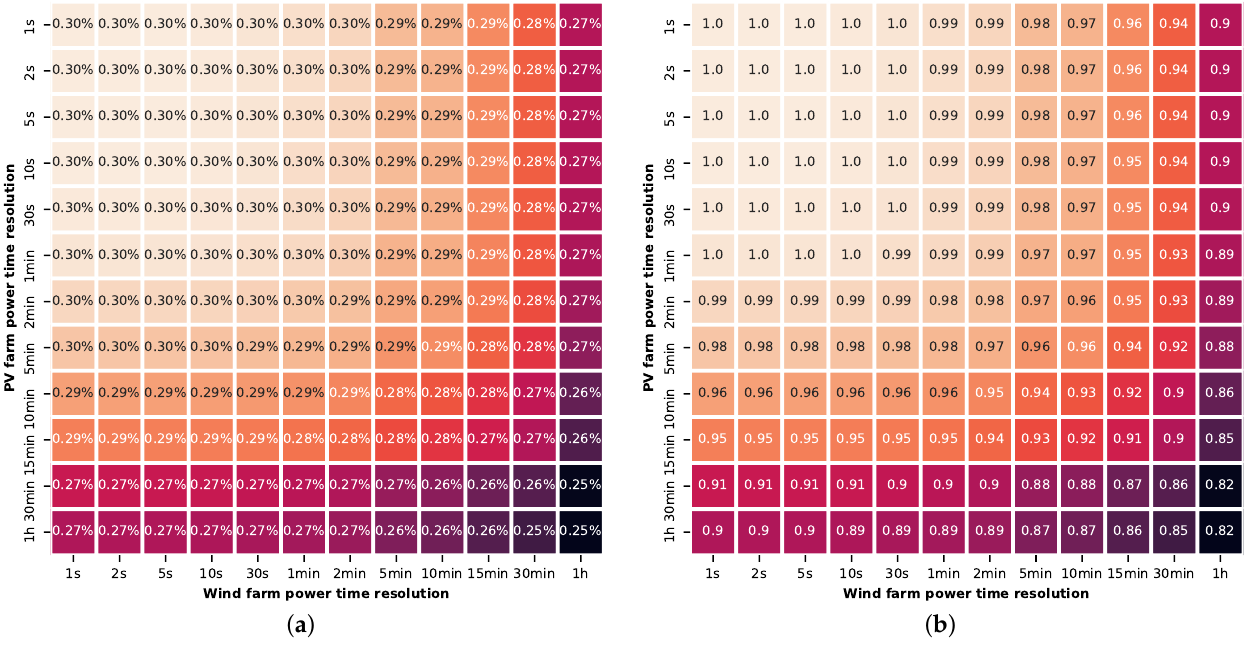
Figure 12. Curtailment losses for summer months (June, July, August) represented as ( a ) Percentage curtailment losses and ( b ) Relative curtailment losses to 1 s wind and solar PV time